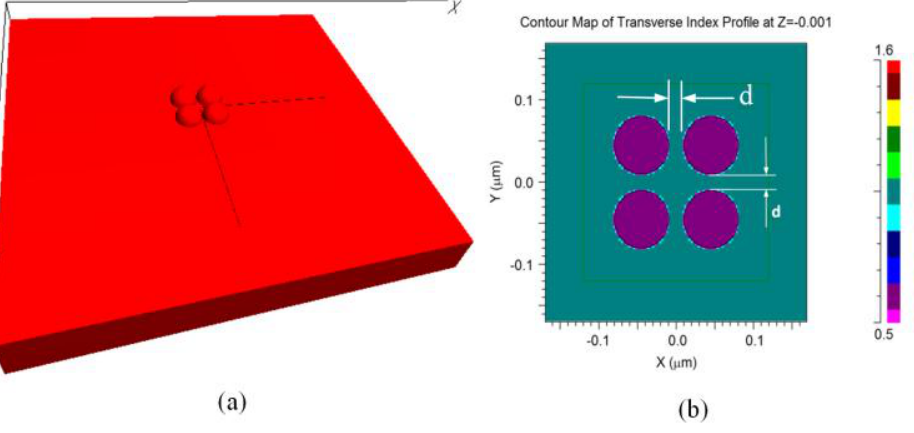
Figure 3. ( a ) FDTD model of the four hemisphere morphology ( b ) refractive index distribution of the FDTD model from the top of the